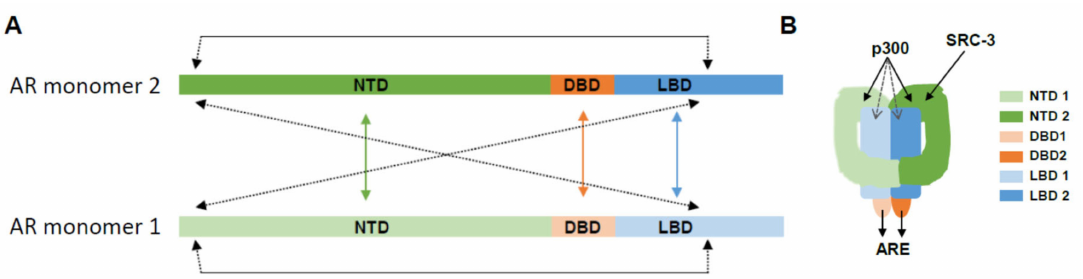
Figure 3. Contribution of AR domain interactions to AR dimerization, AR DNA binding and coregulator recruitment. ( A ) Current working model supports that AR dimerization occurs via intermolecular NTD-NTD, DBD-DBD and LBD-LBD interactions. Inter-and intramolecular NTD- LBD interactions further contribute to active AR conformation and dimerization. ( B ) Schematic representation of 3D AR domain interactions and interactions between AR domains and the AR- associated coregulators p300 and SRC-3. Black arrows, strongest interactions; dashed grey arrows, weak interactions. Data adapted from information provided in reference